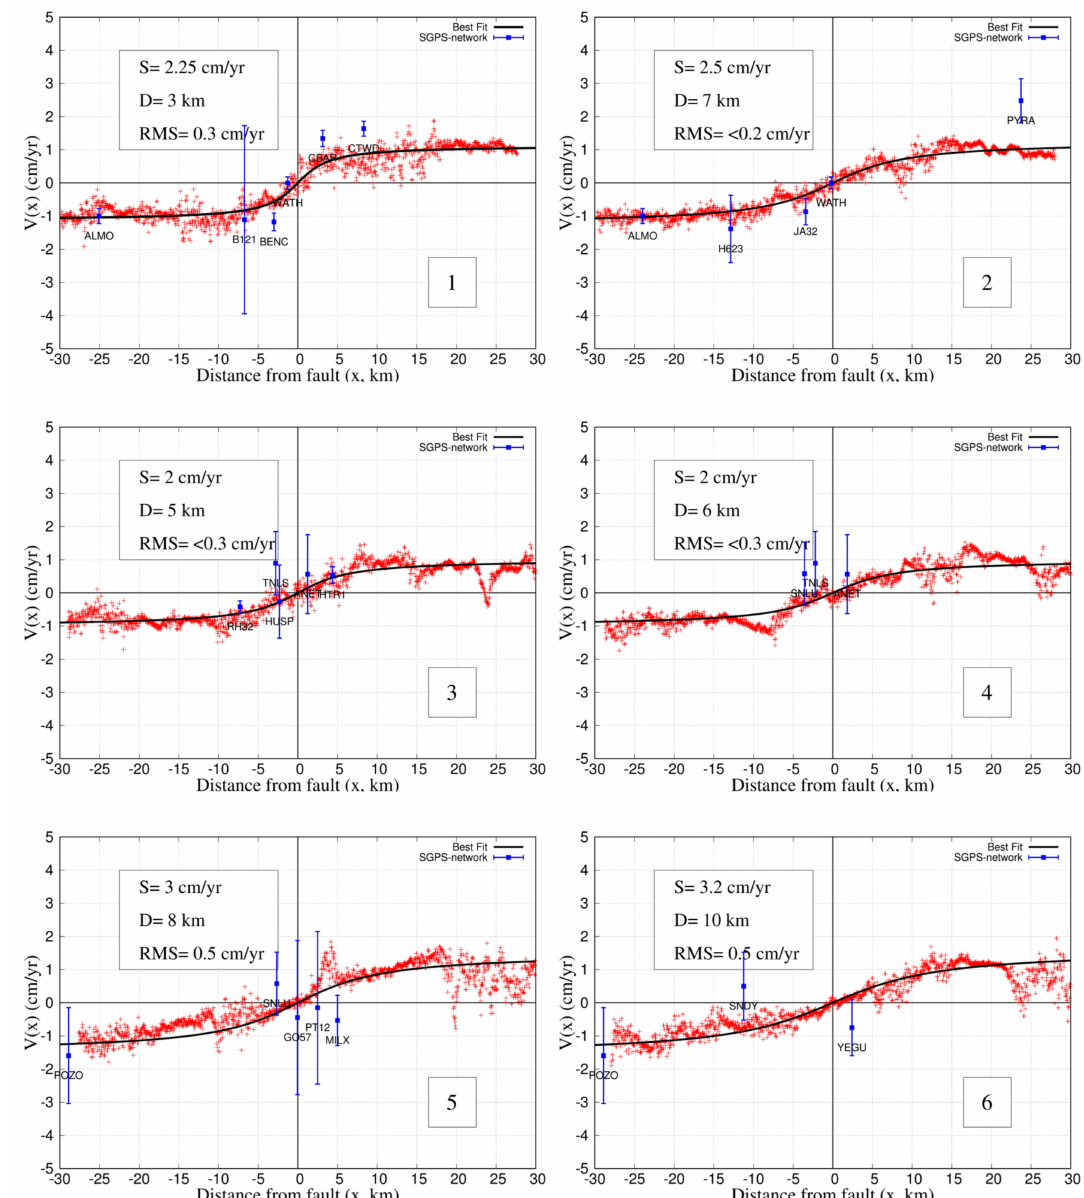
Figure 4. The surface deformation velocity profiles (cm/year) extracted across the Cholame segment (red points) according to the distance from the SAF (km). The black line represents the elastic dislocation model whose calibration parameters (slip velocity S and maximum locking depth D) are recalled. SGPS-derived fault parallel velocities are also presented with the standard deviation as vertical error bars. The corresponding root mean square (RMS) between the presented model and the data is also